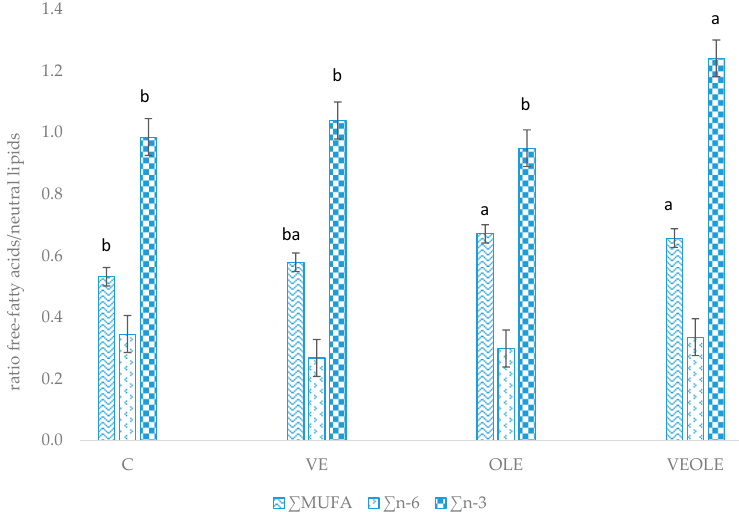
Figure 1. Main fatty acids relative mobilization index (plasma free fatty acids / plasma neutral fatty acids). Different letters (a, b) indicated P < 0.05